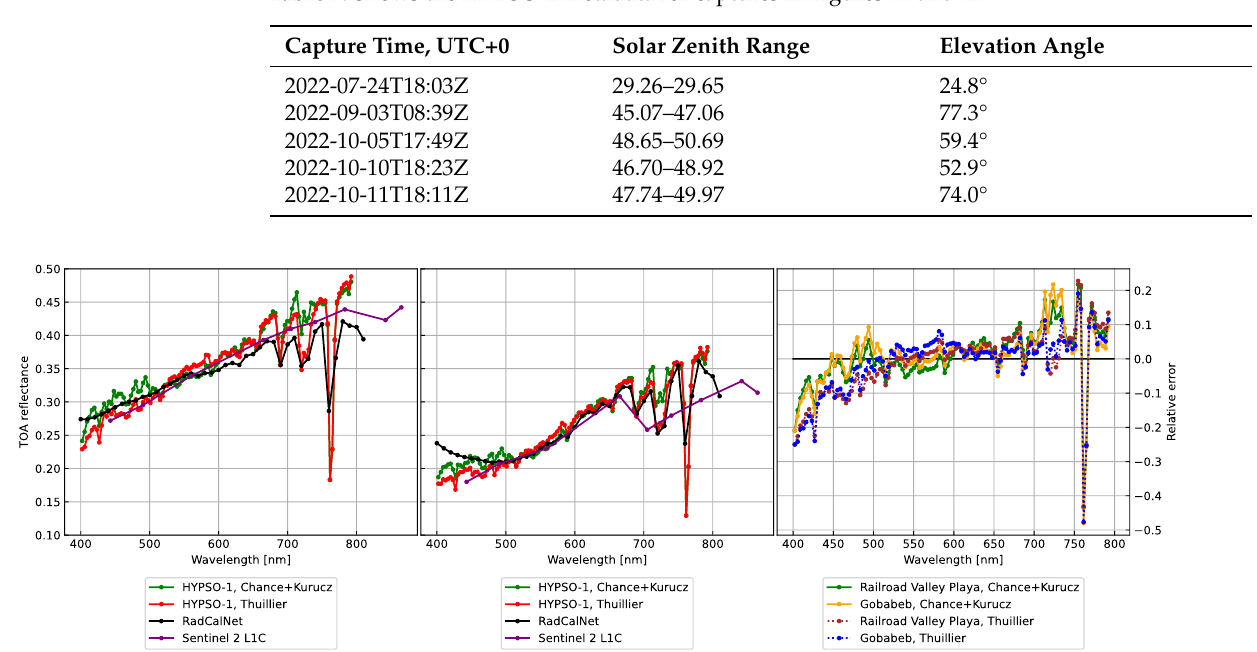
Figure 11. ToA reflectance spectral comparison of HYPSO-1, Sentinel-2, and RadCalNet calibration sites Railroad Valley Playa (left) and Gobabeb (center). Relative error, which is calculated by dividing HYPSO-1 ToA reflectance with RadCalNet ToA reflectance and subtracting 1 (right).